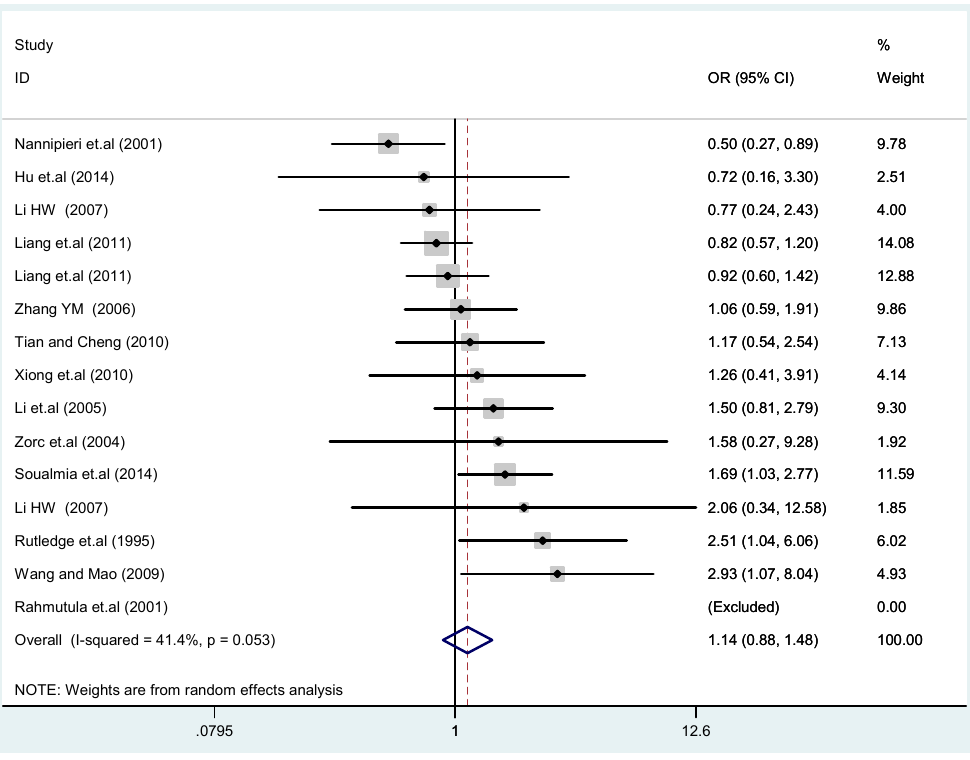
Figure 3. Forest plot of overall population of T2238C co-dominant model-1 (TC vs. TT).